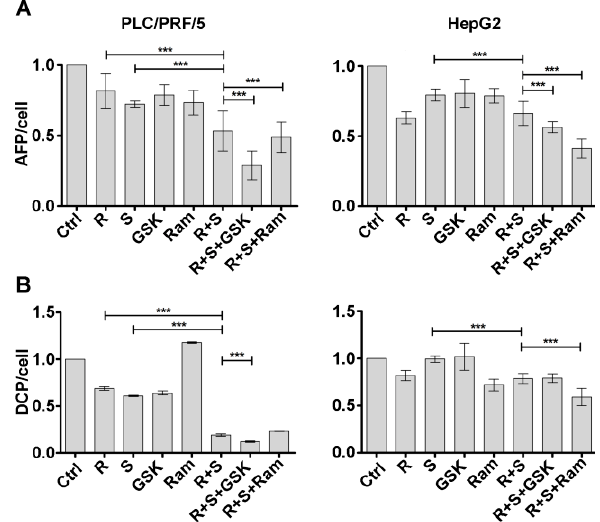
Figure 5. GSK1838705A and ramucirumab potentiate the inhibitory effects of sorafenib/regorafenib combination on AFP and DCP secretion in HCC cells. Cells were cultured with 2.5 µ M (PLC / PRF / 5)